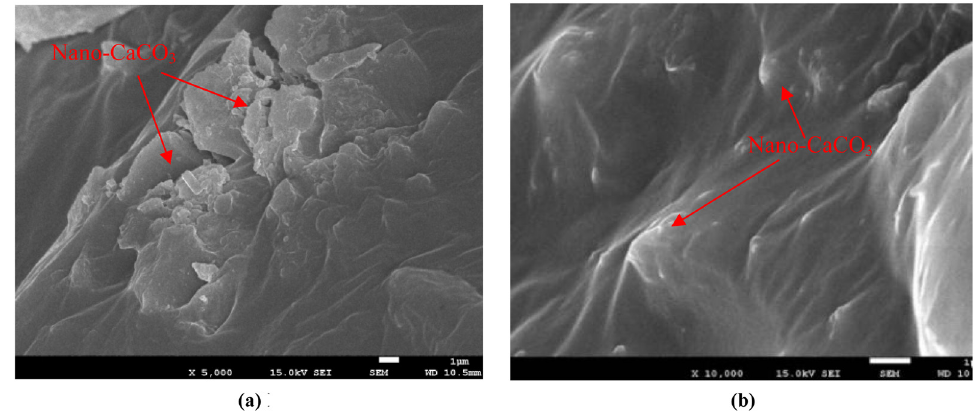
Figure 5: Di ff erent magni fi cation images of nano - CaCO 3 - modi fi ed asphalt: ( a ) nano - CaCO 3 - modi fi ed asphalt ampli fi es 5,000 times and ( b ) nano - CaCO - modi fi ed asphalt ampli fi es 10,000 3